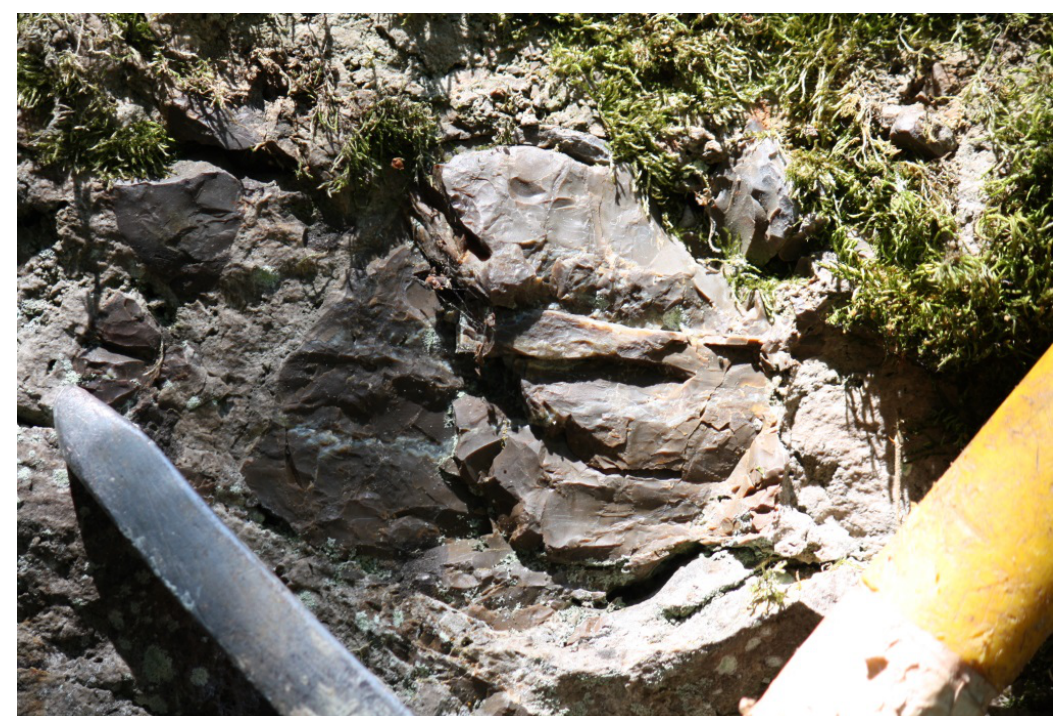
Figure 9. Example of a silicified limestone outcrop at Bergheim (Haut-Rhin) (Photo: M. Delloul, AA).